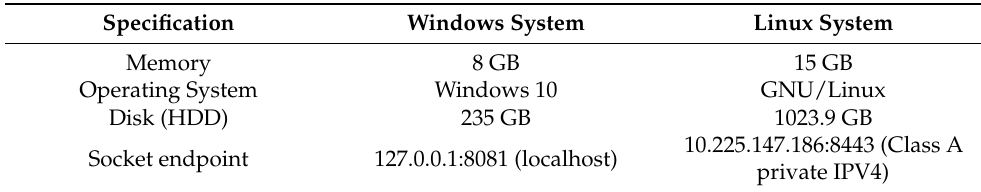
Table 6. Specification of the experimental